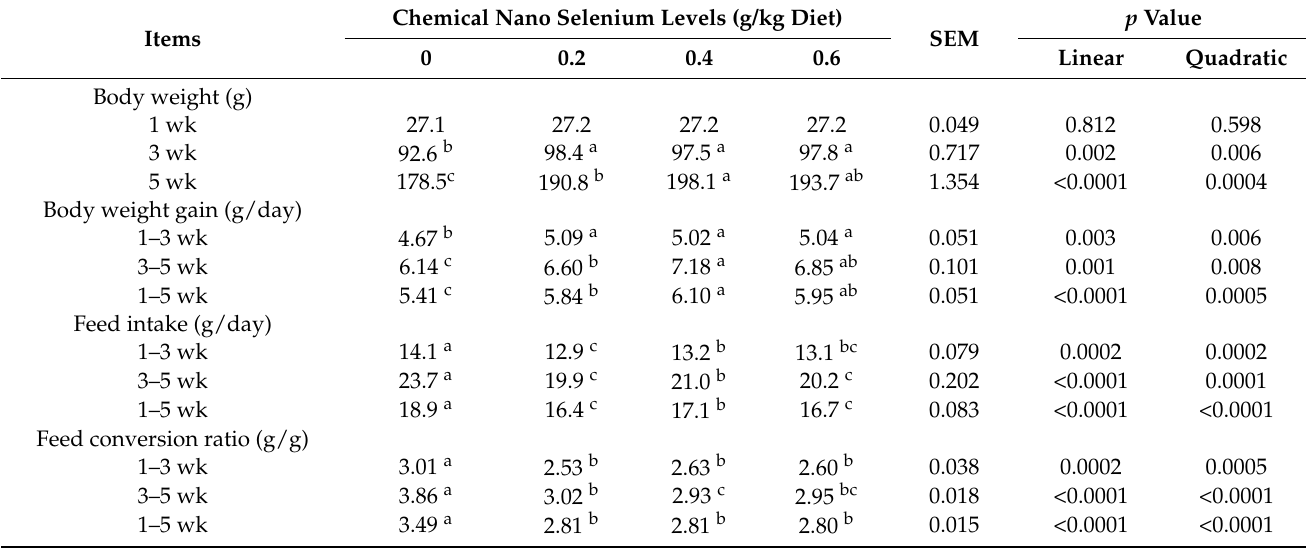
Table 4. Growth performance of growing Japanese quail as affected by dietary